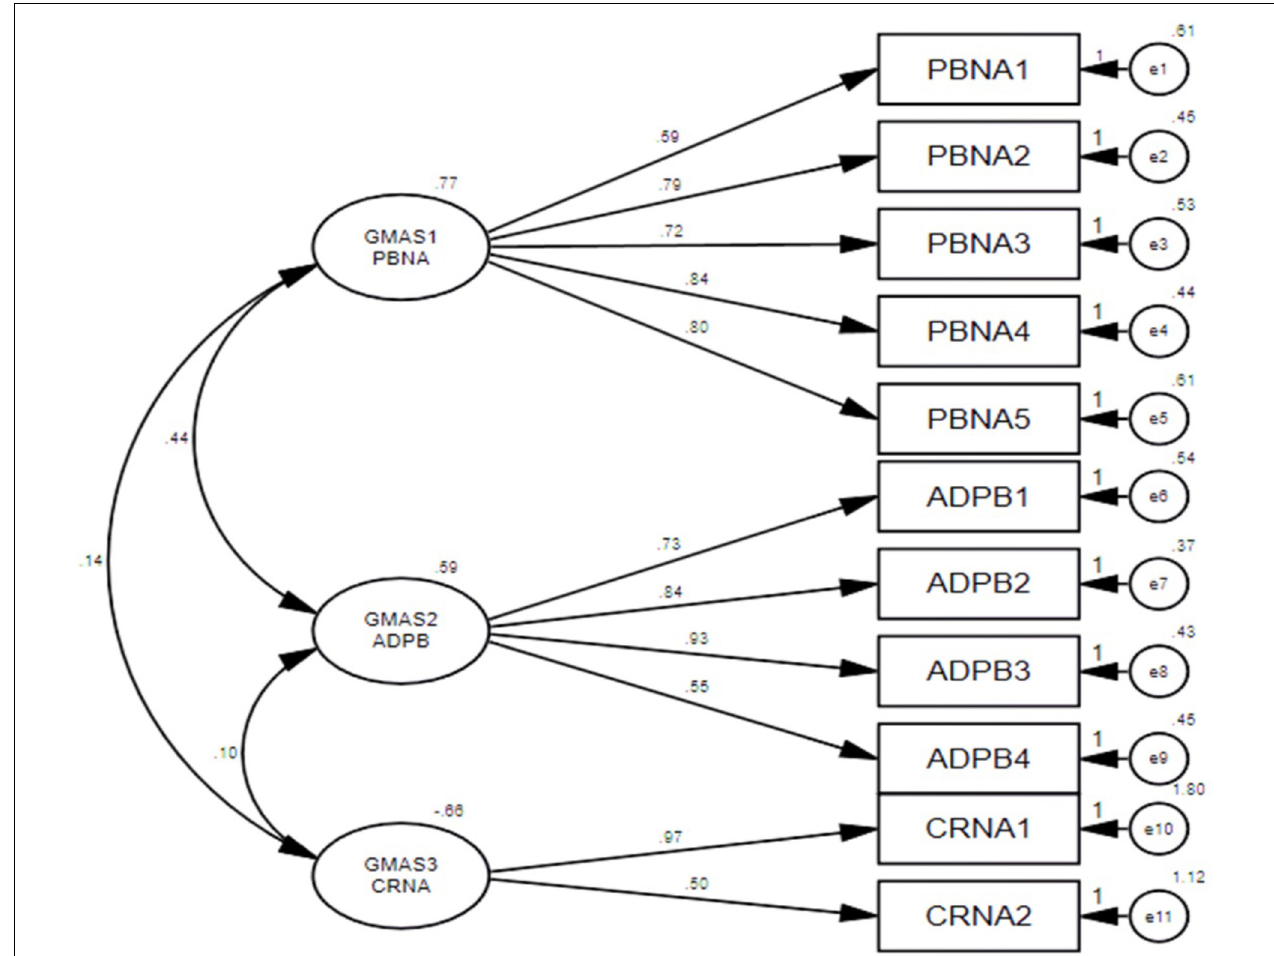
FIGURE 4 | Structure equation model (SEM).